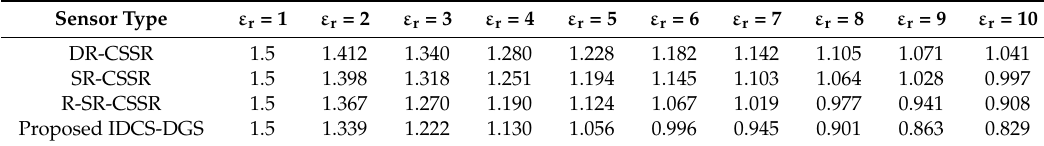
Figure 6. S 21 characteristics of the four permittivity sensors for the varying permittivity of the material under test (MUT): ( a ) DR-CSRR; ( b ) SR-CSRR; ( c ) R-SR-CSRR; ( d ) proposed IDCS-DGS. Table 1. Resonant frequencies of S 21 responses for the four permittivity sensors in